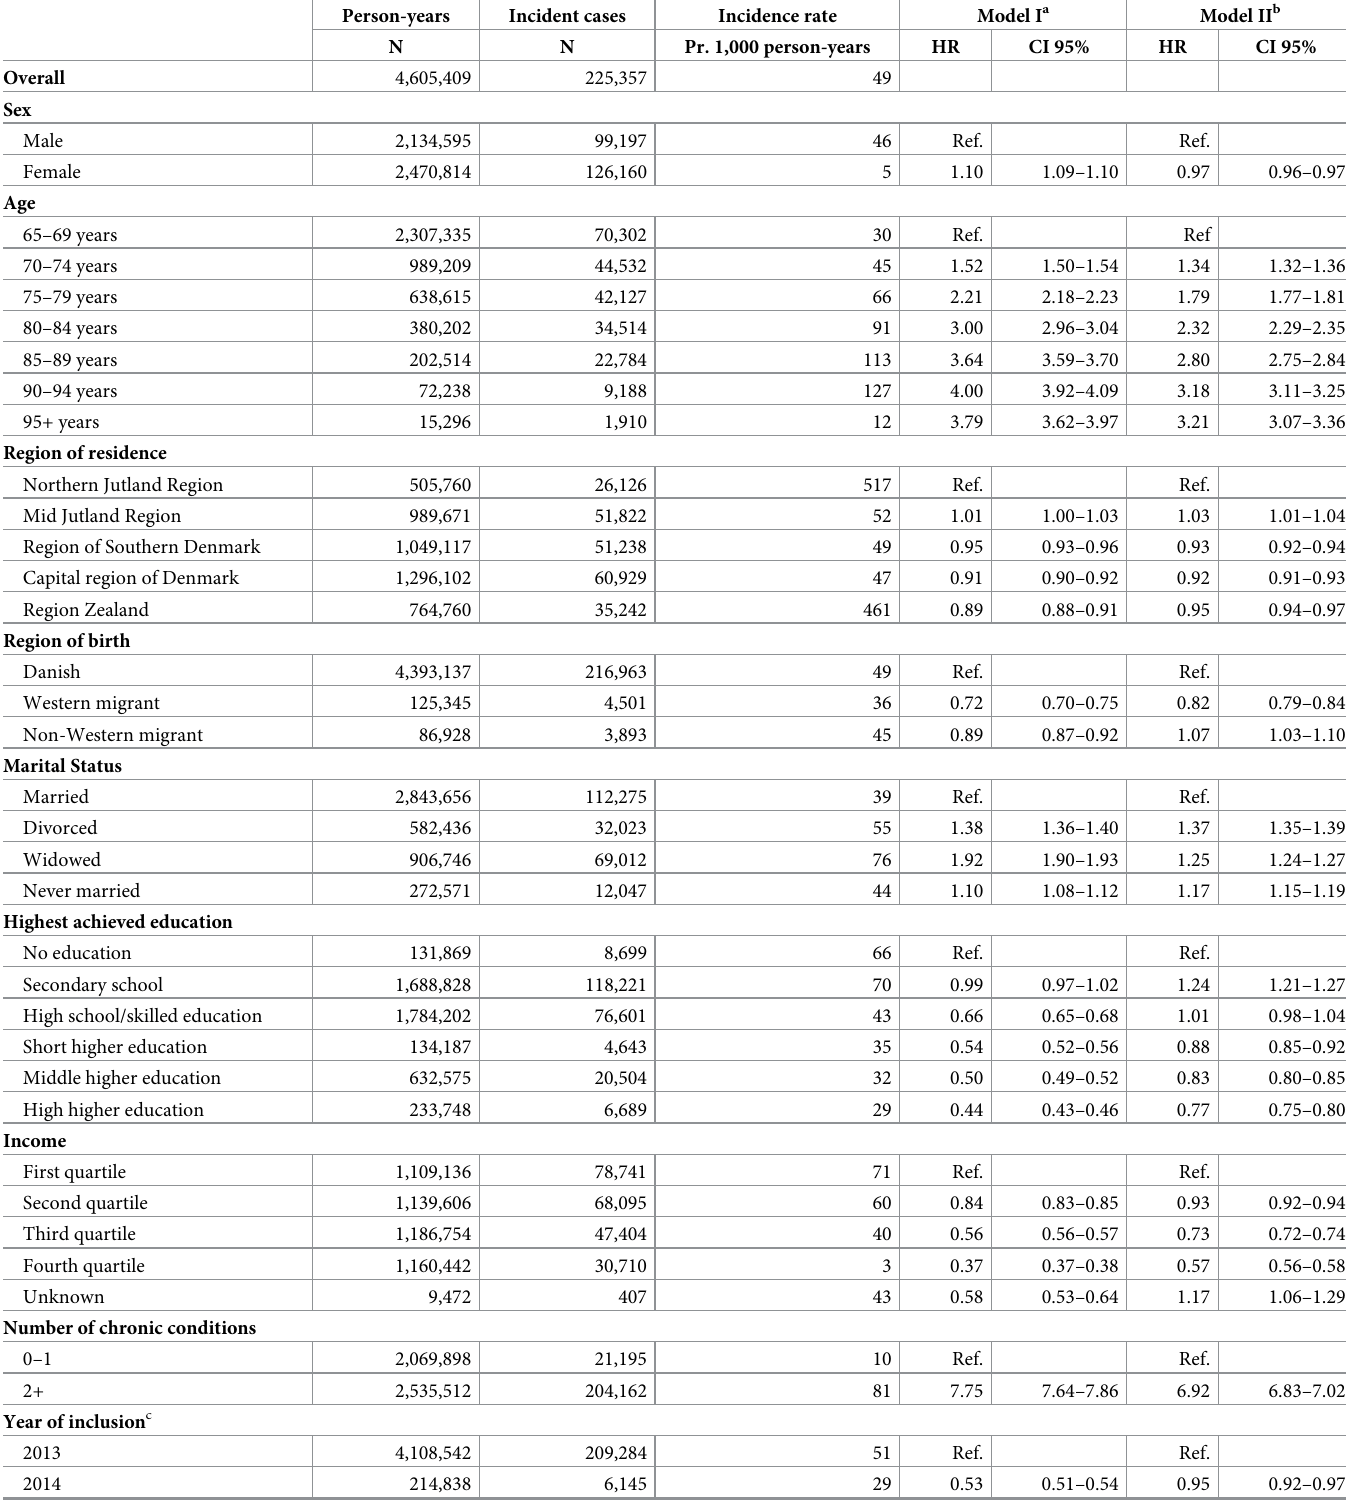
Table 4. Incidence of excessive polypharmacy among the 1,275,731 study participants were not exposed to excessive polypharmacy at the time of